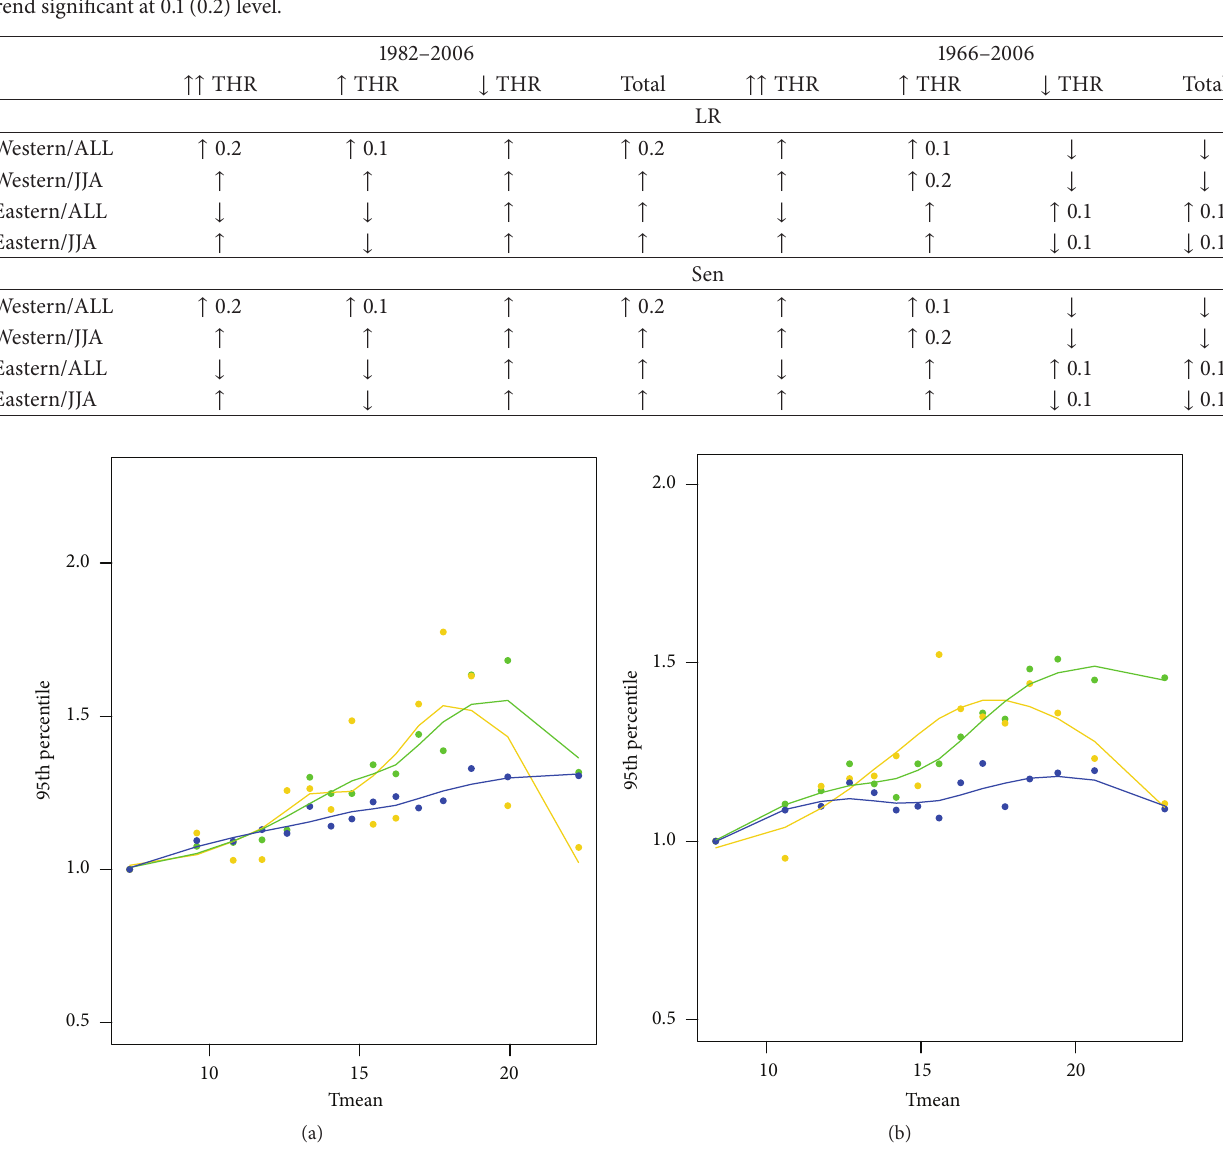
Figure 4: The LOESS-estimated scaling between the Tmean and precipitation of events below the THR (blue) and above the THR (yellow) and total (green) for the western region (a) and for the eastern region (b). The values on 𝑦 -axis were divided by the first value.